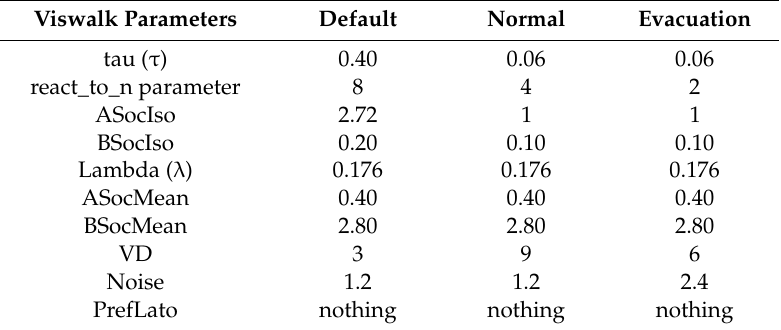
Table 6. Specific pedestrian parameters of Viswalk